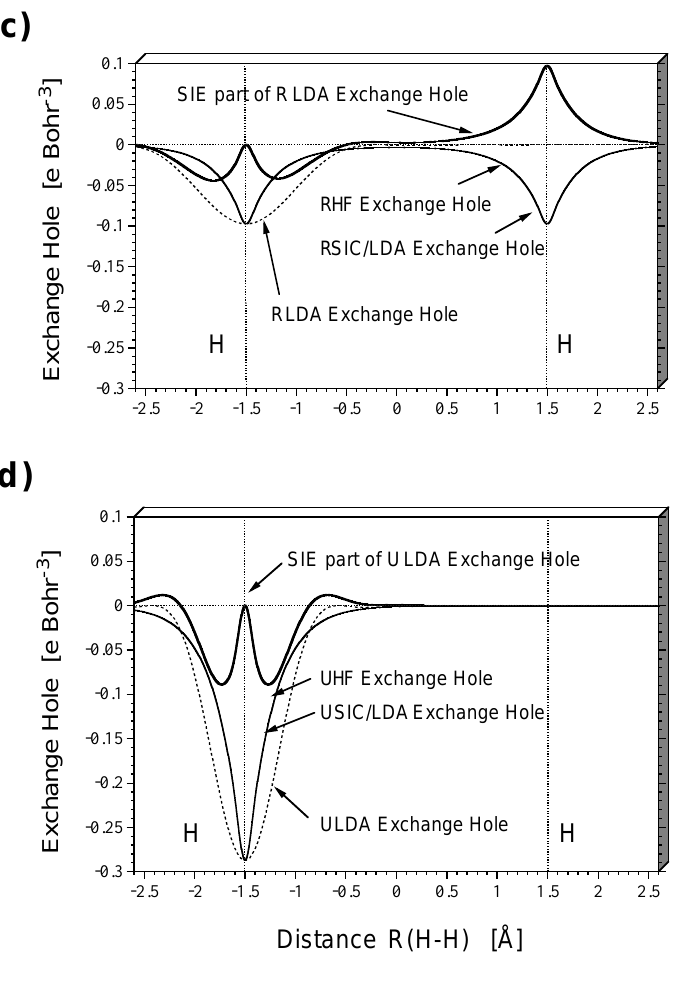
Figure 2: Graphical representation of the exchange hole calculated for the dissociating H 2 ( 1 Σ + the bond axis for the situation that the reference electron is at the left H nucleus (position P1). The SIE part of the LDA exchange hole is given by the line in bold print. a) R(H-H) = 1.5 ˚A: RHF, RSIC/LDA (both the normal line), and RLDA (dashed line) calculations. b) R(H-H) = 1.5 ˚A: BS-UHF, BS-USIC/LDA (both the normal line), and BS-ULDA calculations. c) R(H-H) = 3.0 ˚A: RHF, RSIC/LDA (both the normal line), and RLDA (dashed